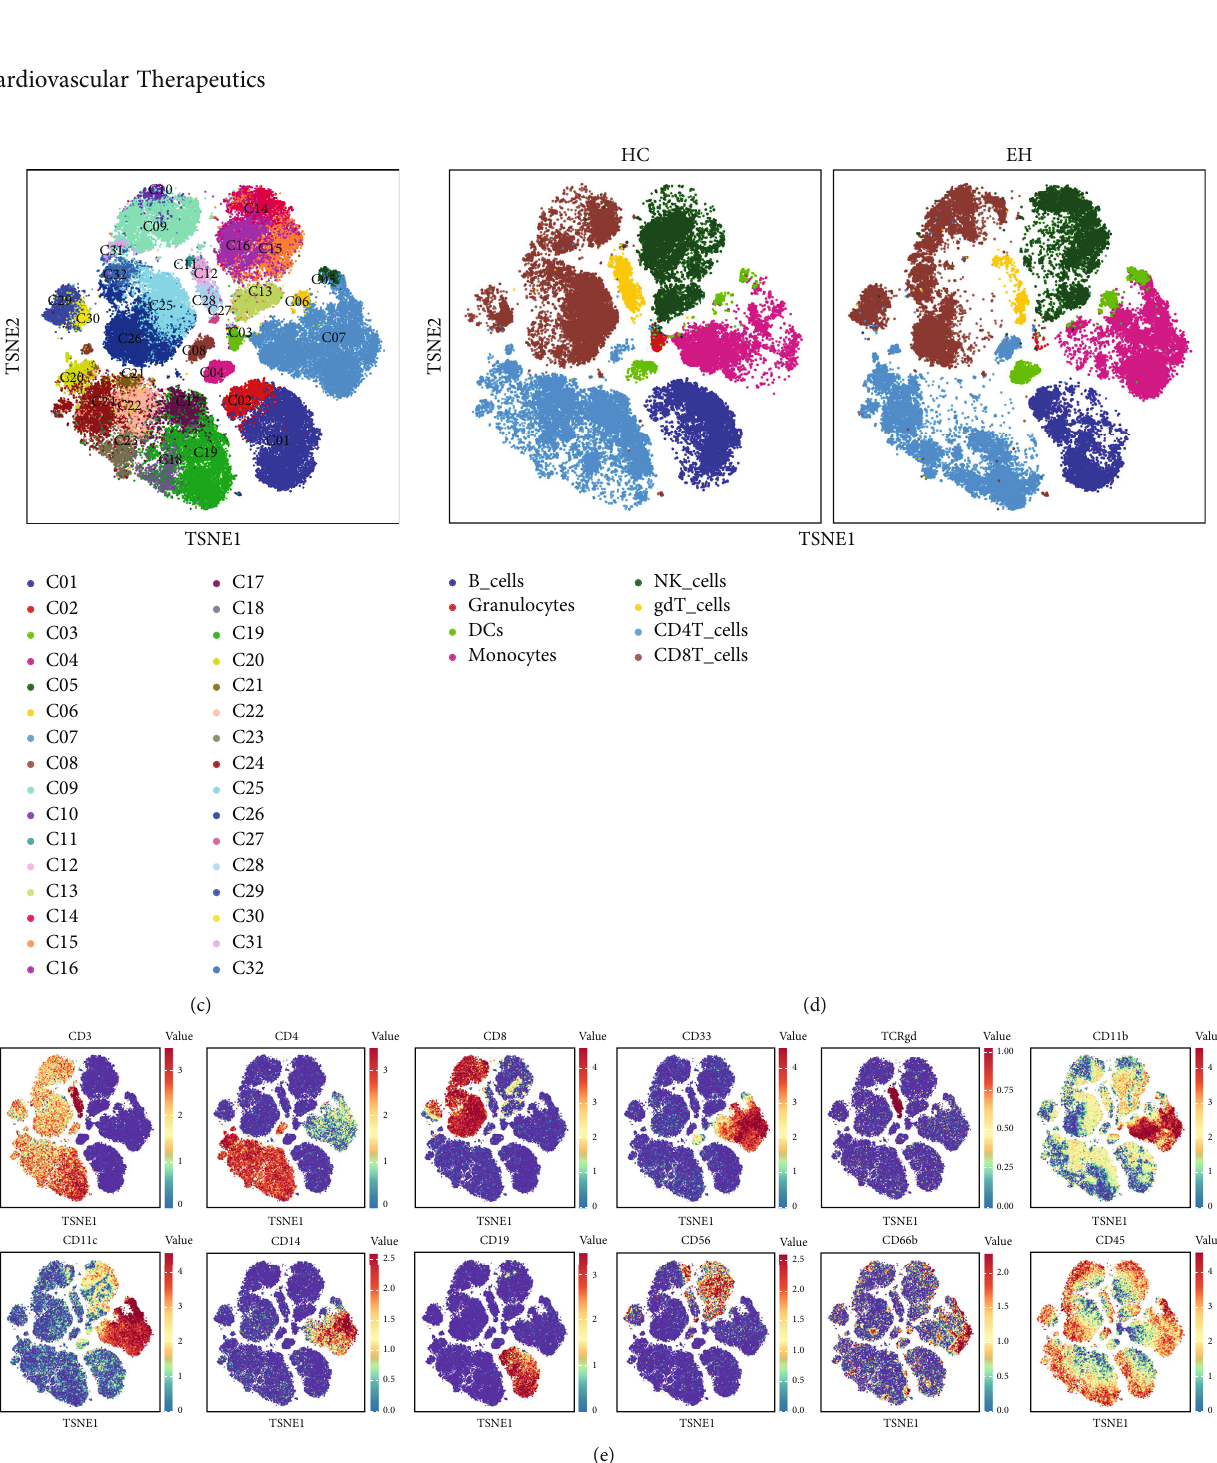
Figure 1: Single-cell mass cytometry analysis of peripheral blood samples and data visualization. (a) The experimental fl ow chart. (b) Heat map of “ clusters vs. markers. ” The percentage of each cell cluster is shown on the right of the heat map. The median value of each marker expression in each cell cluster is indicated by the shade of color. (c) Dimensional reduction visualization of merge samples. The 32 cell clusters are distributed in the T-SNE plot, marked with di ff erent colors. (d) T-SNE plots of cell subsets from HC and EH. Di ff erent colors indicate di ff erent types of cells. (e) The distribution of cell lineage markers in di ff erent lineage